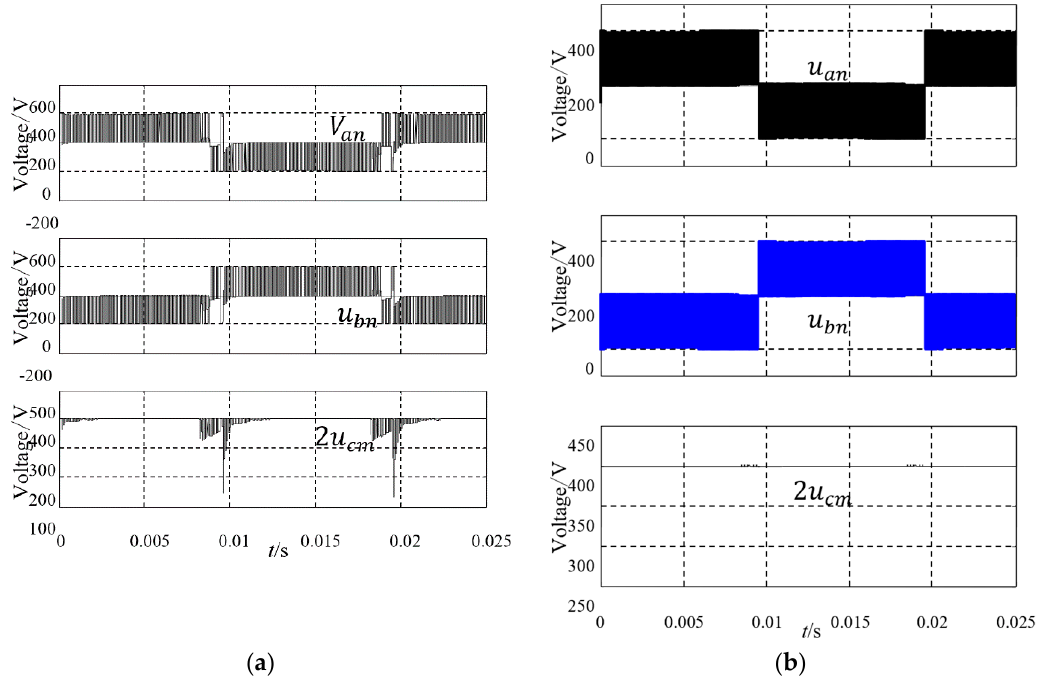
Figure 14. Common-mode voltage. ( a ) Common-mode voltage of modulation mode I, θ = 30 ◦ .